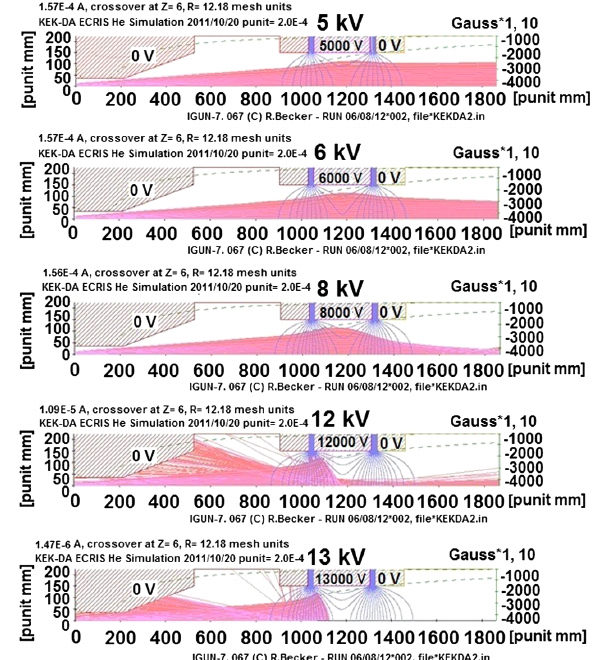
FIG. 7. Comparison of the simulated and measured voltage waveforms for pulse durations of 3 and 5 (cid:1) s .